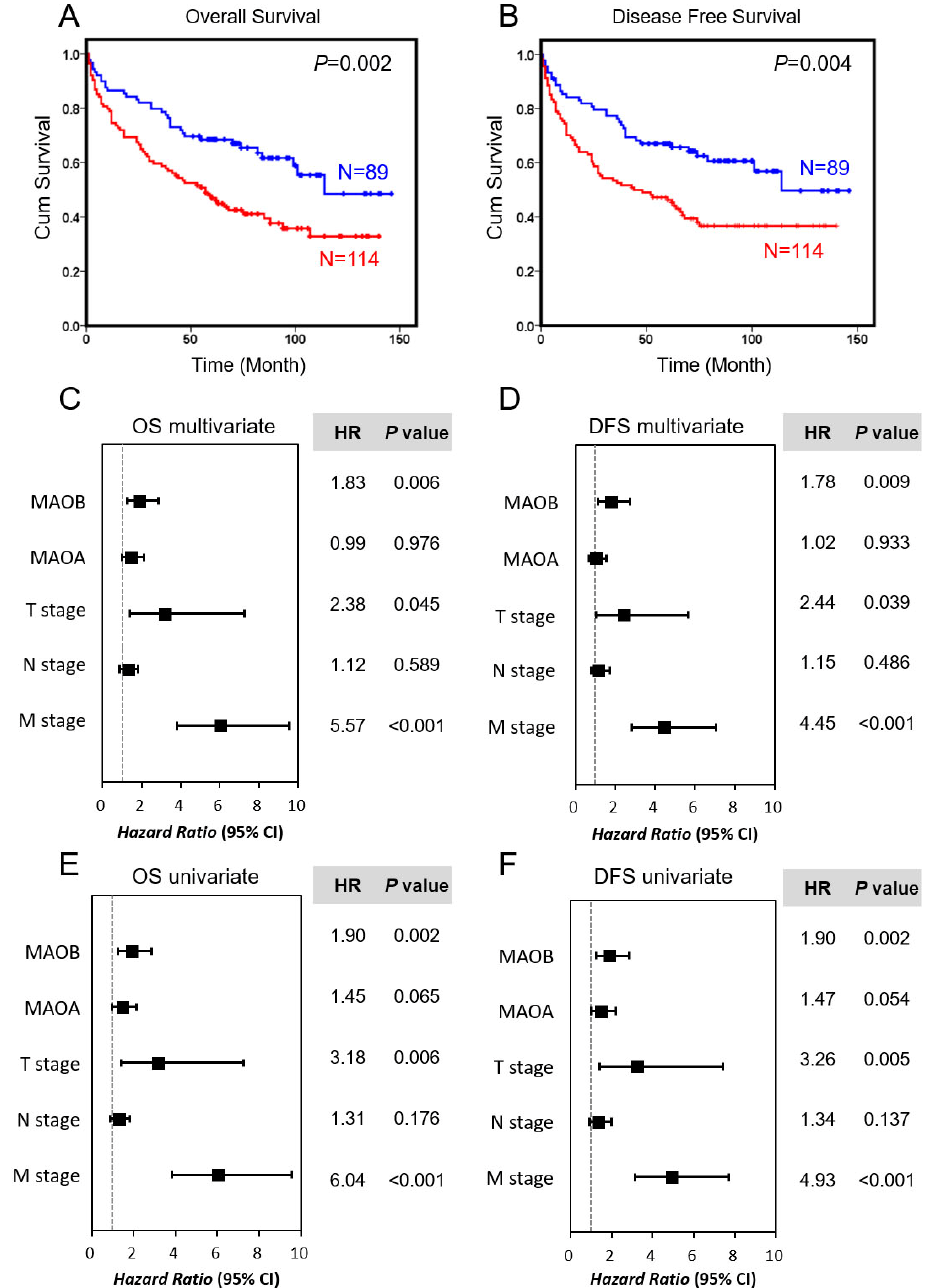
Figure 4. Prognostic value of monoamine oxidase B (MAOB) in colorectal cancer. ( A , B ) Kaplan–Meier plots of overall survival (OS) curves ( A ) and disease-free survival (DFS) curves ( B ) for MAOB in colorectal cancer patients. The red line indicates high expression of MAOB, and the blue line indicates low expression. ( C , D ) Forest plots of the multivariate analysis for hazard ratios (HRs) using a Cox regression model in OS ( C ) and DFS ( D ). ( E , F ) Forest plots of univariate analysis for HRs using a Cox regression model in OS ( E ) and DFS ( F ). The p -value was calculated.